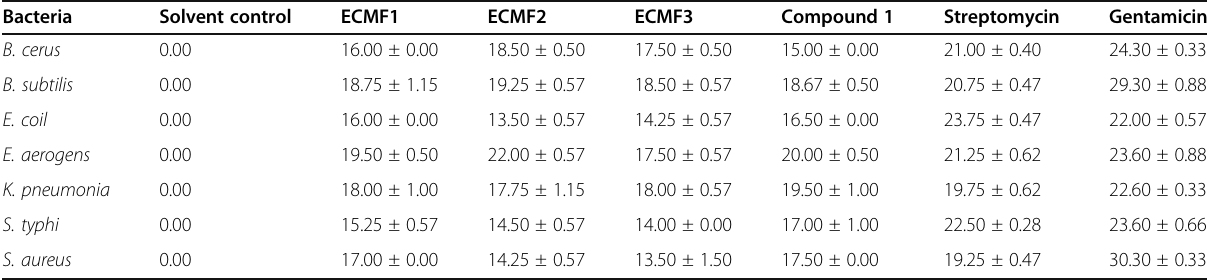
Table 4 Antibacterial activity of methanol fractions and compound 1 of E. cotinifolia against human pathogenic bacteria (in mm)